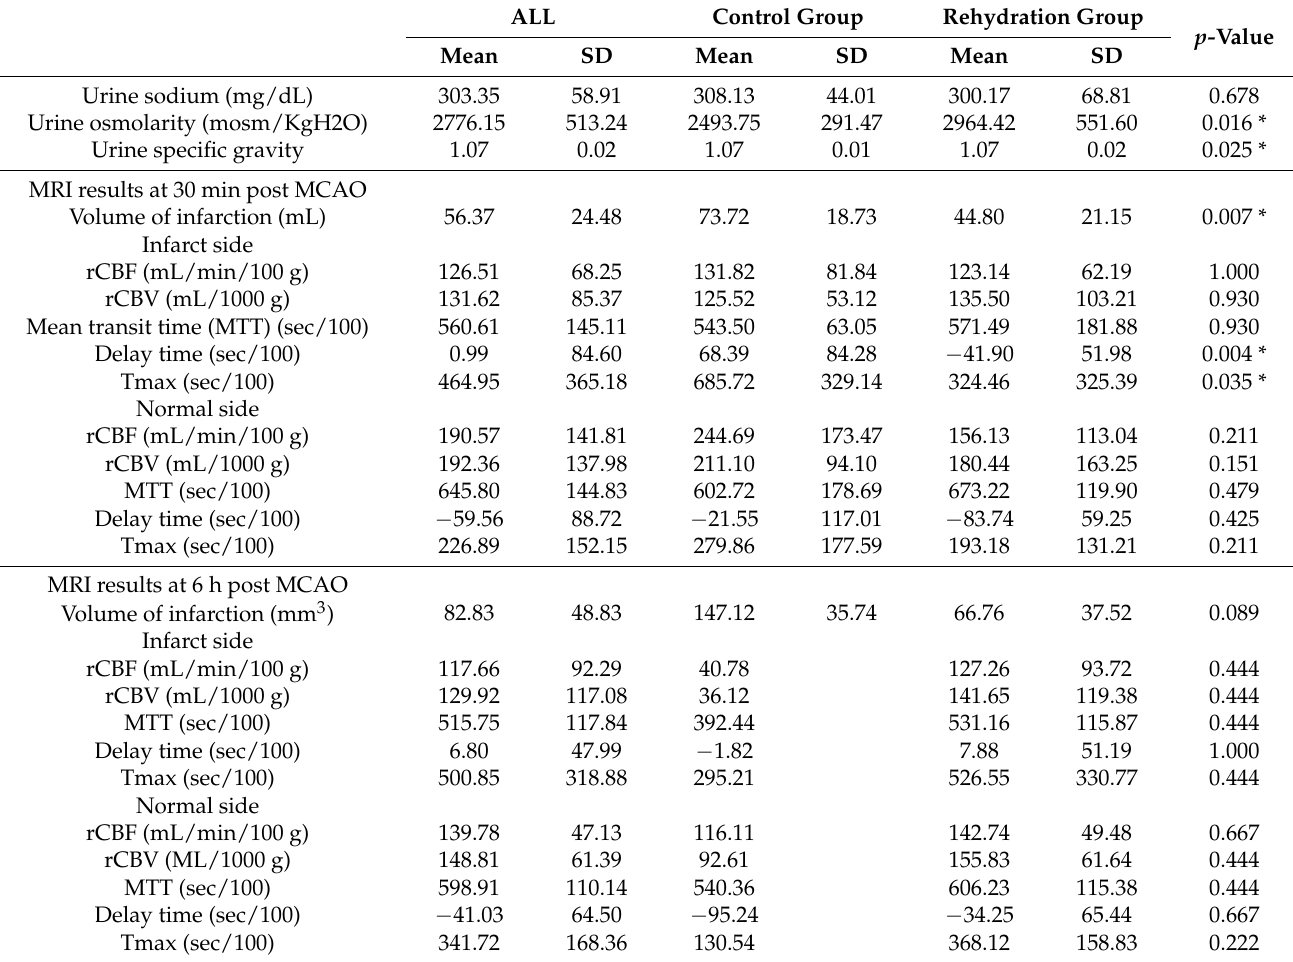
Table 1. Comparison of the infarct volume and brain perfusion in the two groups.